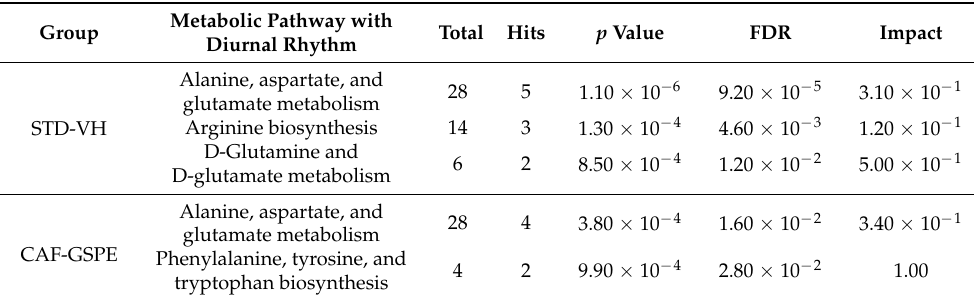
Table 5. Rhythmic metabolic pathways detected at ZT12 in iWAT.